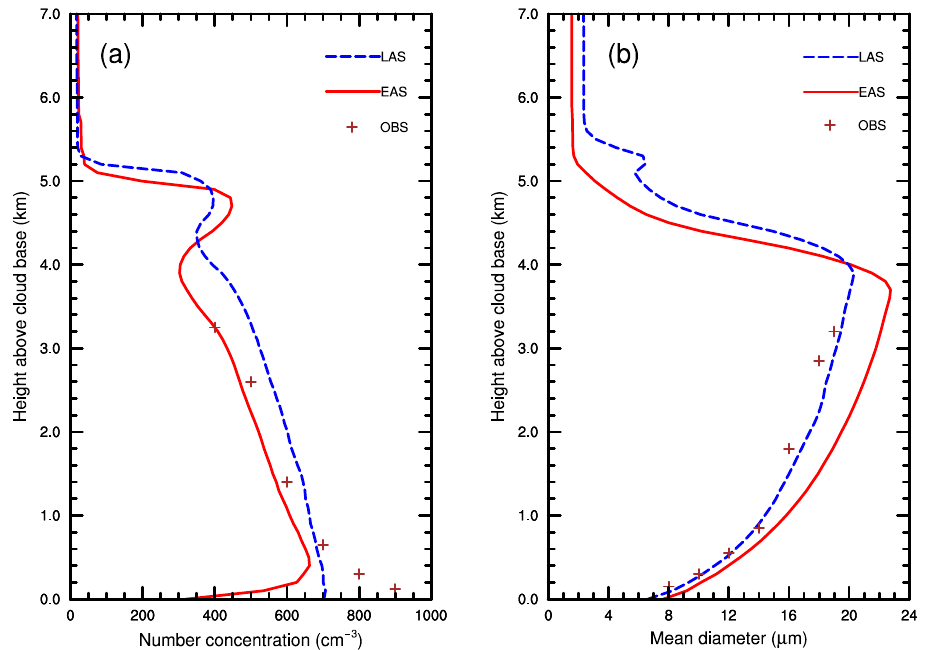
Figure 5. Comparisons between model results at 52.5 min with Lagrangian advection scheme (LAS), Eulerian advection scheme (EAS), and observations by the sailplane (OBS). ( a ) Particle number concentration. ( b ) Particle mean diameter.